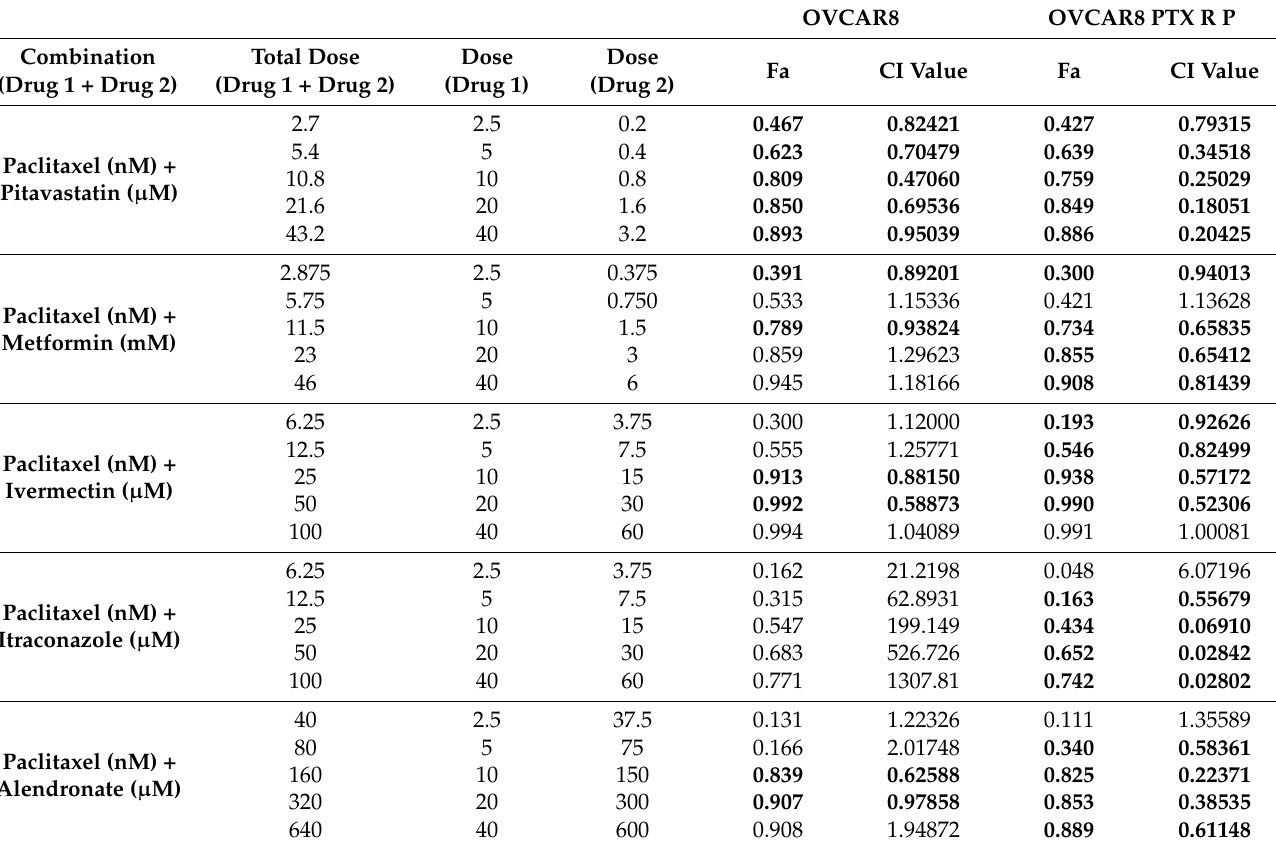
Table 1. Fractional effect (Fa) values and respective combinatory index (CI) values showing drug synergism of OVCAR8 and OVCAR8 PTX R P cells, after exposure to a fixed-dose ratio that corre- sponds to 0.25, 0.5, 1, 2 and 4 times the individual IC 50 values of each drug for 48 h. The combined treatment was co-administered at the same time. All assays were performed in triplicate in at least three independent experiments. CI > 1 (antagonism), CI = 1 (additivity) and CI < 1 (synergism, bold). OVCAR8 OVCAR8 PTX R